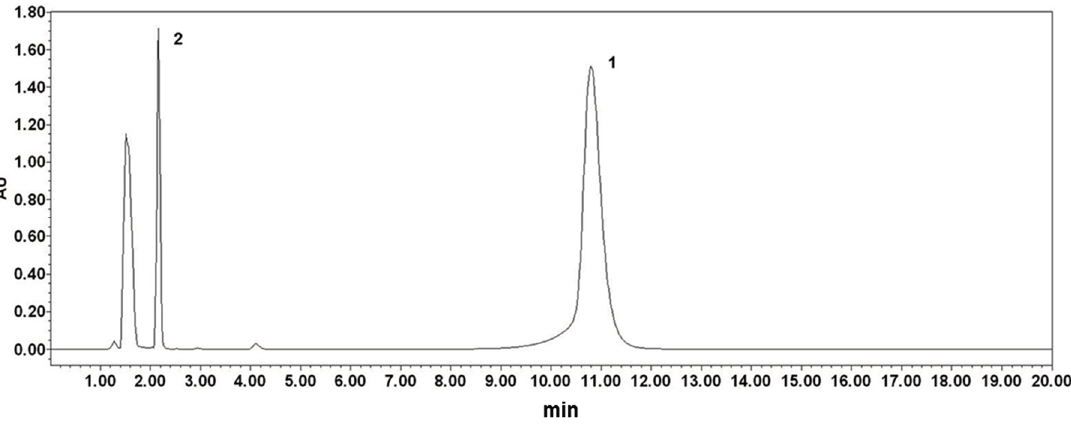
Figure 2. The profile of phloretin ( 1 ) and phloretin 3',3-disulfonate ( 2 ) by HPLC.